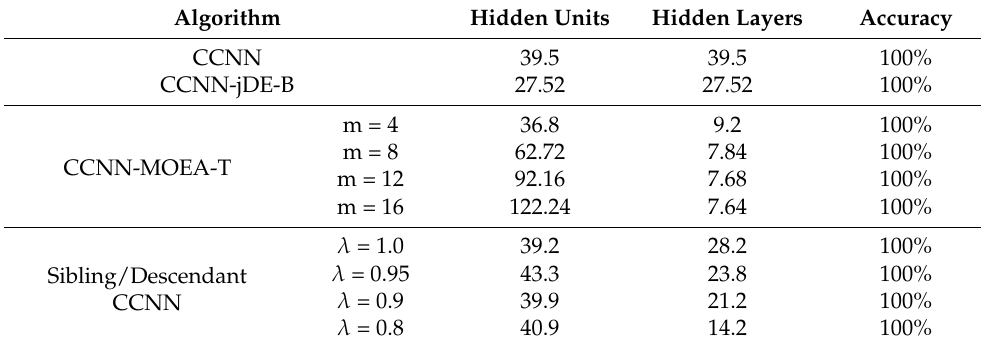
Table 2. The simulation results of each algorithm on the four spirals classification problem. Algorithm